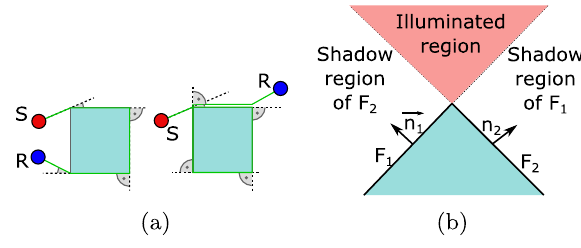
Figure 5. (a) Two diffracted propagation paths. On the left building, the path is diffracted around the entire building with an accumulated diffraction angle u A > p . The right building shows a diffracted path with u A > 2 p . Depending on the angular threshold value, these paths are dismissed. (b) Wedge with aligned faces F 1 and F 2 . Propagation paths to edges that are completely located in the illuminated region of both aligned faces (red area) are diffracted neither from the shadow region of F 2 nor from the shadow region of F 2 .